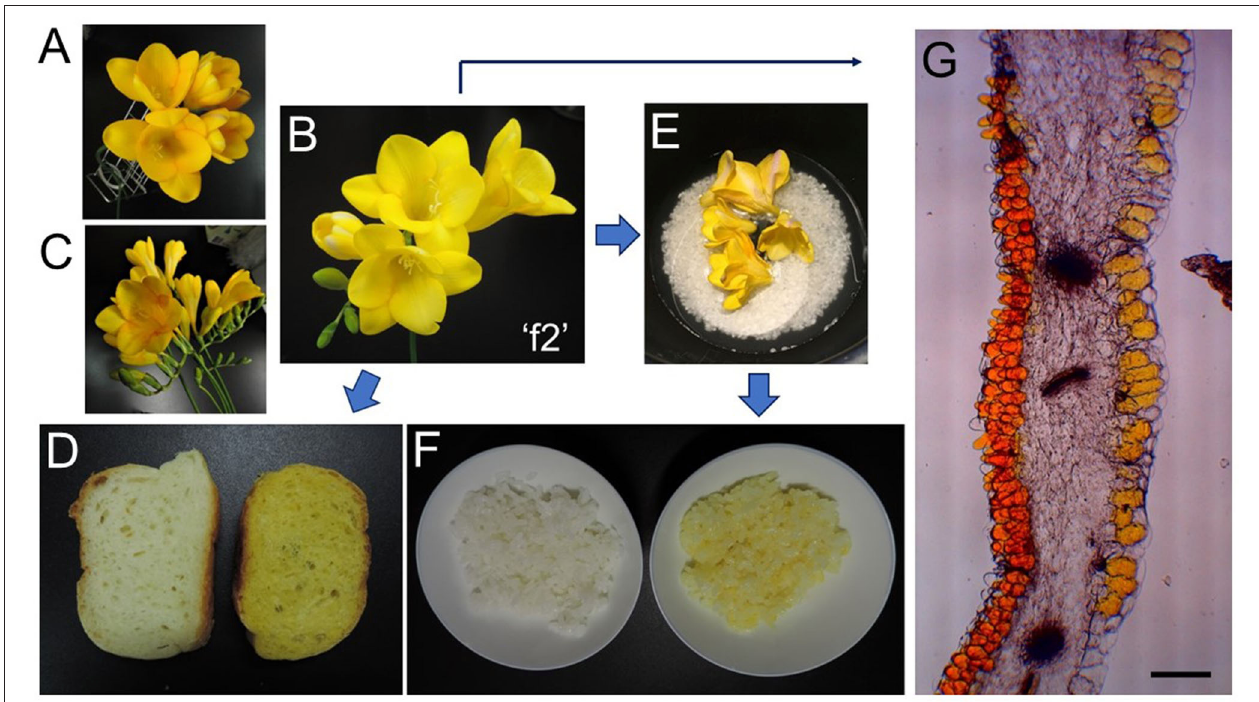
FIGURE 2 | Freesia-relevant pictures: (A) , freesia ( Freesia x hybrida L.) cultivar “Aladin;” (B) , freesia cultivar “Ishikawa f2 go” (“f2”); (C) , freesia cultivar “Kayak;” (D) , bread baked without (left) and with (right) freesia “f2” flowers; (E) , before cooking with freesia “f2” flowers by a rice cooker; (F) , rice cooked without (left) and with (right) freesia “f2” flowers; (G) , microscopy image of a freesia “f2” petal (Bar represents 200 µ m).